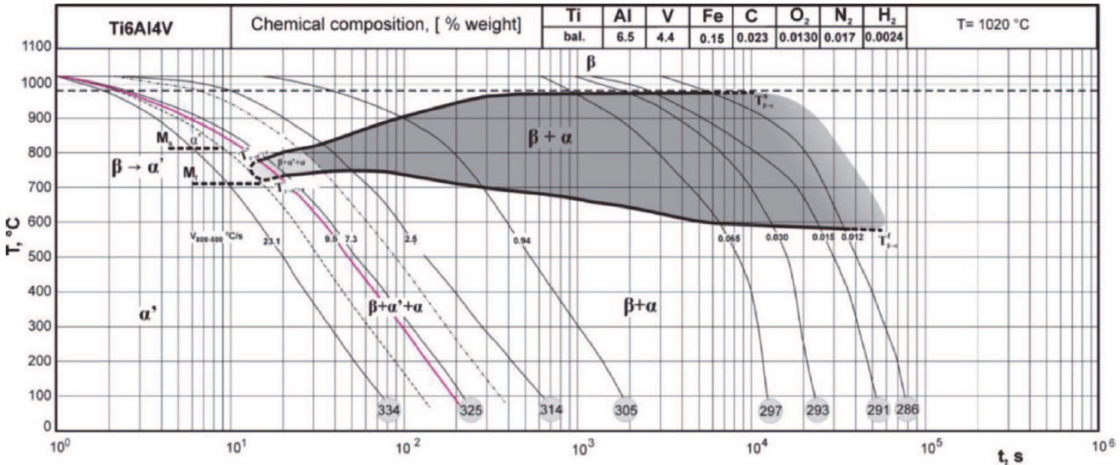
Figure 3. Experimental CCT diagram for Ti6Al4V, with both M s, α (cid:48) and M f, α (cid:48) values. Reprinted with permission from ref. [47]. Copyright 2011 PAN Journals